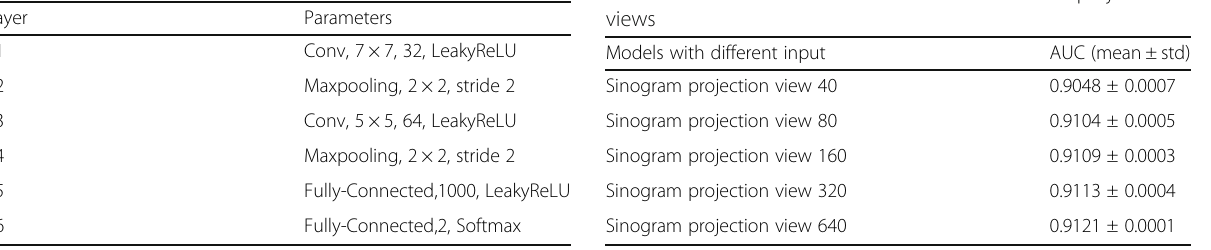
Table 1 Convolutional neural network model settings for single channel input Table 2 Area under the curve values with different